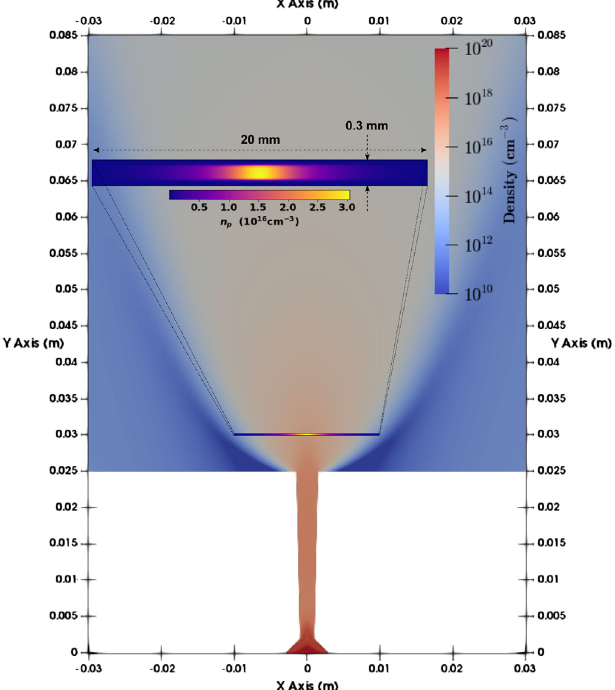
FIG. 4. Gas jet density profile at the mid-plane of the 3D OpenFOAM simulation at time step 140 μ s. Insert: magnification of laser-ionized plasma density profile. An electron beam ’ s trajectory would be into the